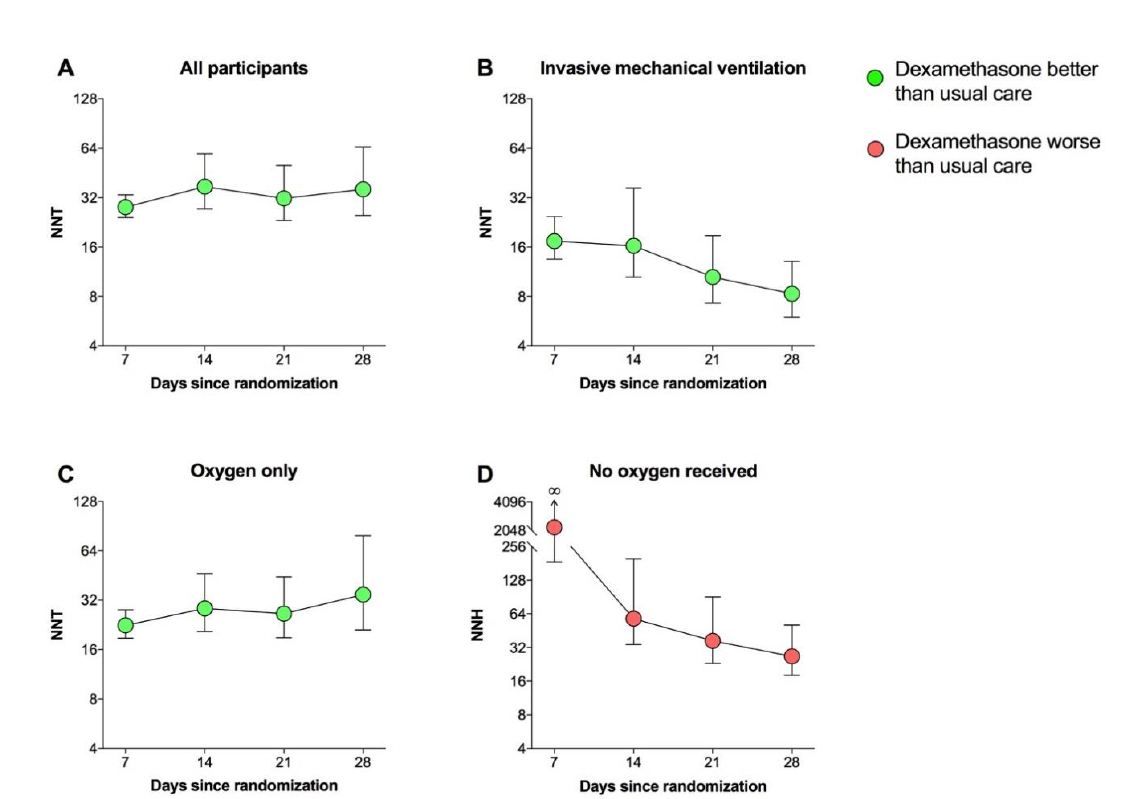
Figure 1. Graphical representation ( A – D ) of NNT and NNH with 95%CI of dexamethasone vs. usual care on mortality at 7, 14, 21, and 28 days according to respiratory support as reported by the RECOVERY study in patients hospitalized with COVID-19. ∞: infinity; CI: confidence interval; NNH: number needed to harm; NNT: number need to treat.